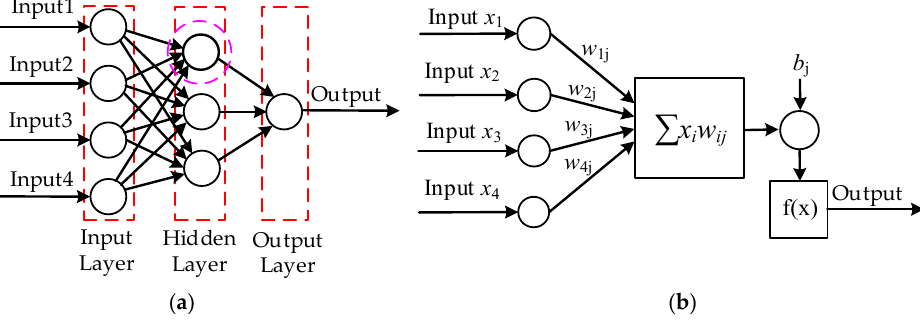
Figure 11. The diagram of the neural network, ( a ) Structure of BP neural network ( b ) Structure of the j -th neurons in the hidden layer.